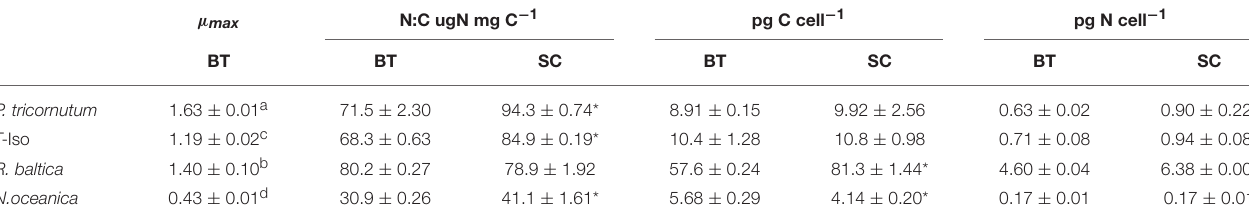
TABLE 1 | Maximum specific growth rate ( µ max d − 1 ), N:C ratio, carbon, and nitrogen content per cell for four microalgae species from batch and semi-continuous culture.